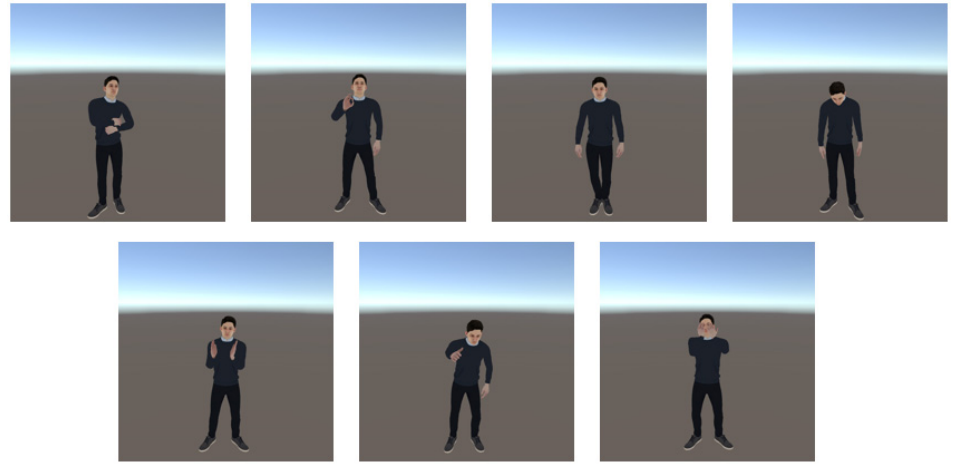
Figure 5. Examples of virtual human motion that we set up as candidates: the virtual human’s motion types consisted of idle, applause, shy, surprised, and so on.